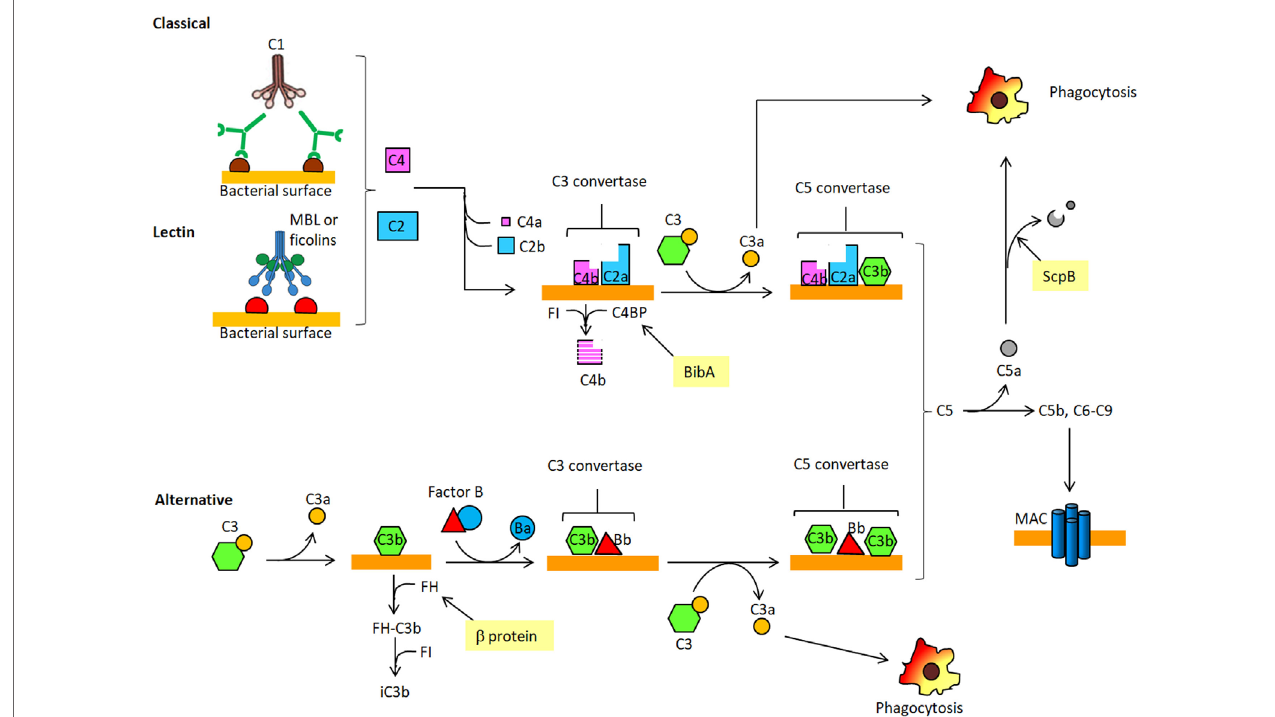
FiGURe 2 | Schematic overview of the complement. The complement cascade is activated when antibody-coated bacteria are recognized by C1 complex of the classical pathway (CP). Alternatively, the complement cascade can be activated after binding of mannose-binding lectin (MBL) to sugars displayed on bacterial surface and complex so formed associates with the serine protease MASP [lectin pathway (LP)]. Both C1 and MASP cleave C4 and C2 to produce C3 convertase complex (C4bC2a) on the microorganism surface. C3 convertase cleaves C3 into C3a, an anaphylotoxin, and C3b, which binds covalently to the bacterial surface. The C3 convertase (C3bBb) of the alternative pathway (AP) is generated after complex formation between the activated product of B (Bb) and surface bound C3b. C3b also concurs to generate C5 convertases, C4bC2aCb3b and C3bBbC3b, which cleave C5 into C5a, a chemotactic peptide that attracts neutrophils to the site of infection. C5a can be inactivated by the proteolytic attach of ScpB. C5b, the other product of C5 cleavage, forms a complex with C6–9 proteins to generate the membrane attack complex (MAC). C4BP, recruited on the bacterial surface by BibA, is a cofactor of a serine protease factor I (FI) which cleaves C4b, thus preventing the formation of the classical C3 convertase. Factor H (FH) captured by β protein on GBS surface controls the activity of the complement alternative pathway by binding C3b and facilitating its cleavage by